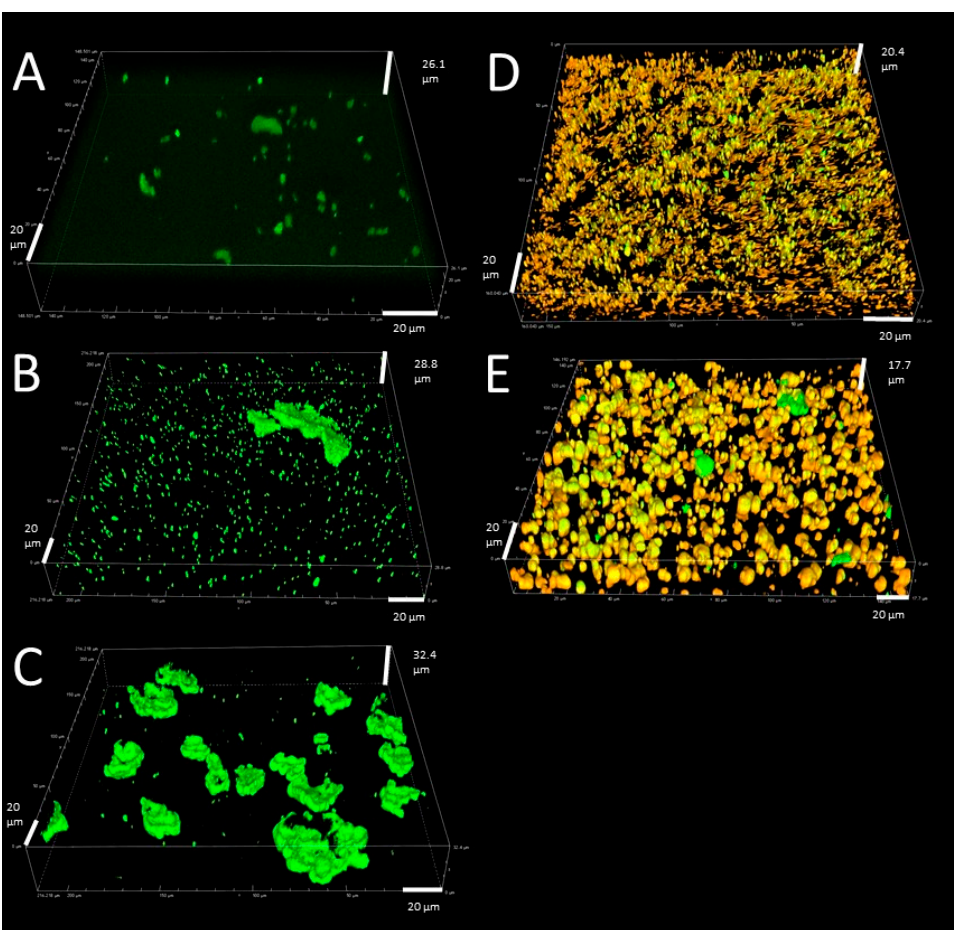
Figure 1. Confocal laser scanning microscopy images of growth of Listeria monocytogenes in food model systems with varying microstructural complexity (adapted from [13], with permission from American Society for Microbiology—Journals, 2021). Bacterial cells and fat droplets are shown in green and orange, respectively. The liquid/gelled aqueous phase was not stained and is, hence, shown by the absence of colour. The growth morphology of the bacteria clearly depends on the microstructural aspects of the food (model) system: ( A ) single cells, small aggregates and small mi- crocolonies in a simple low-viscosity liquid system; ( B ) a large number of small aggregates and small microcolonies and some larger microcolonies in a liquid system with increased viscosity; ( C ) microcolonies of different sizes in an aqueous gel model system; ( D ) small aggregates and microcolonies growing in the spaces between fat droplets and around the fat droplets in an emulsion model system; ( E ) small aggregates and microcolonies growing in the spaces between the fat droplets and around the fat droplets in a gelled emulsion model system.